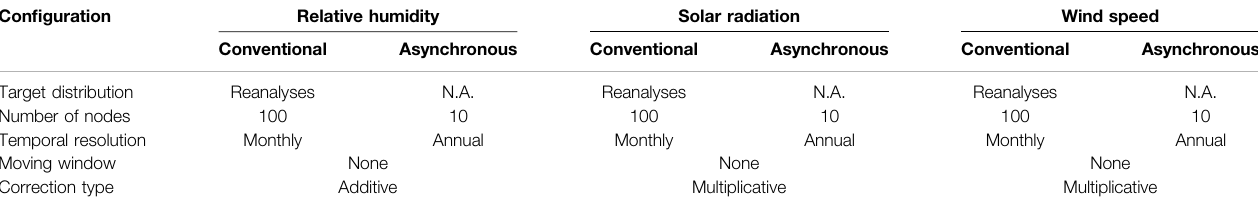
TABLE2| Quantilemappingofrelativehumidity,solarradiationandwindspeedforbothconventionalandasynchronouscon fi gurationsofthehydroclimaticmodelingchain. Con fi